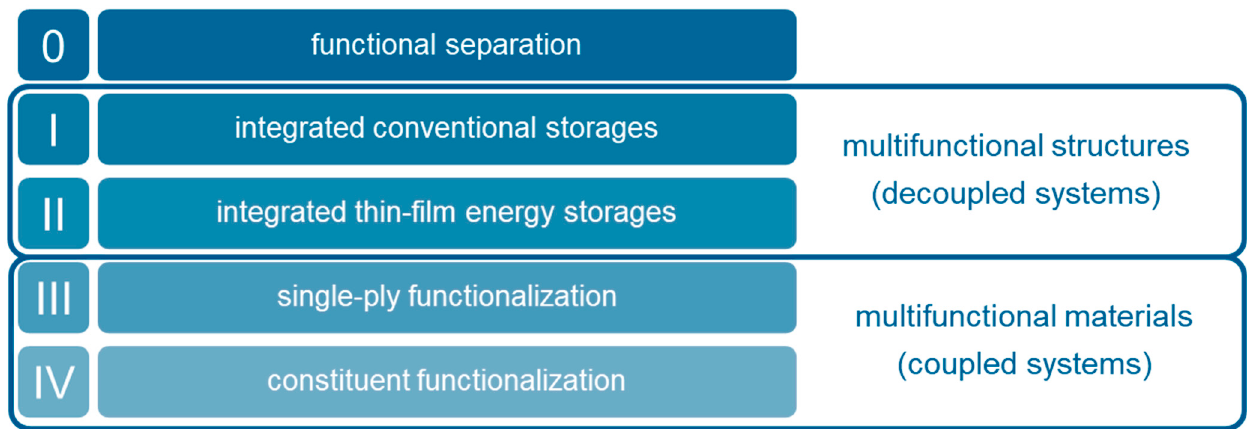
Figure 1. Classification system of structural batteries, adopted from [7].